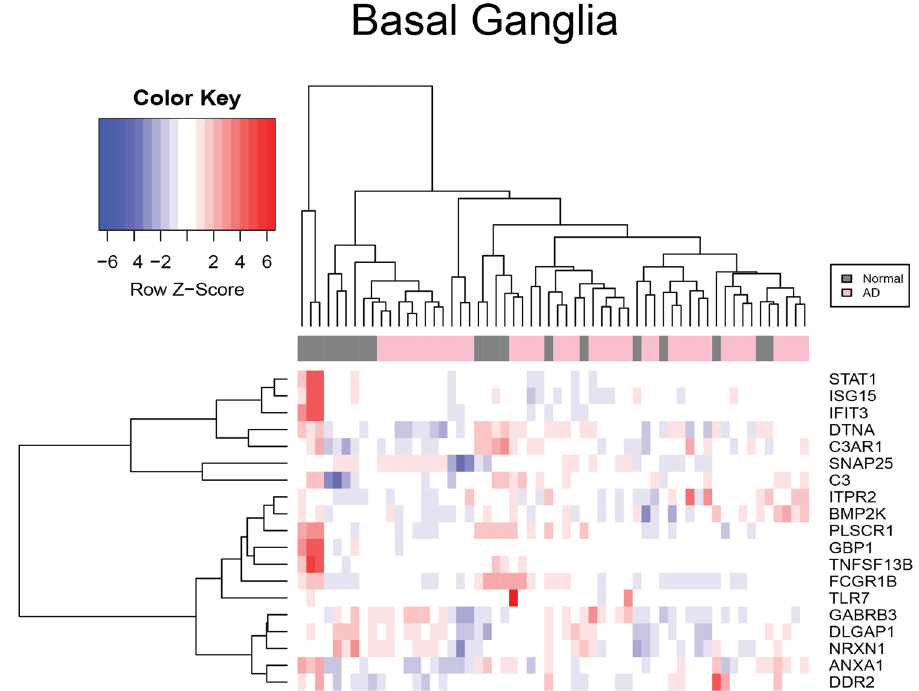
Figure 5. Heatmap of mRNA expression in the basal ganglia of AD patients. This figure represents the expression value of mRNA from the basal ganglia regions of AD and control patients’ brains in GSE84422. The data were normalized using the GCRMA Bioconductor package. The mRNA expression of PLSCR1, DTNA, BMP2K, IFIT3, DDR2, ITRP2, TLR7, ANXA1, GBP1, SNAP25, NRXN1, DLGAP1, GABRB3, STAT1, ISG15, C3AR1, and C3 were chosen by comparing independent SAM results and identifying common markers that were shared between pathologies. The color key represents the Z score the blue represents underexpression and red represents overexpression. Based on SAM results ISG15, GBP1, STAT1, PLSCR1, and DTNA were overexpressed in the basal ganglia of AD subject